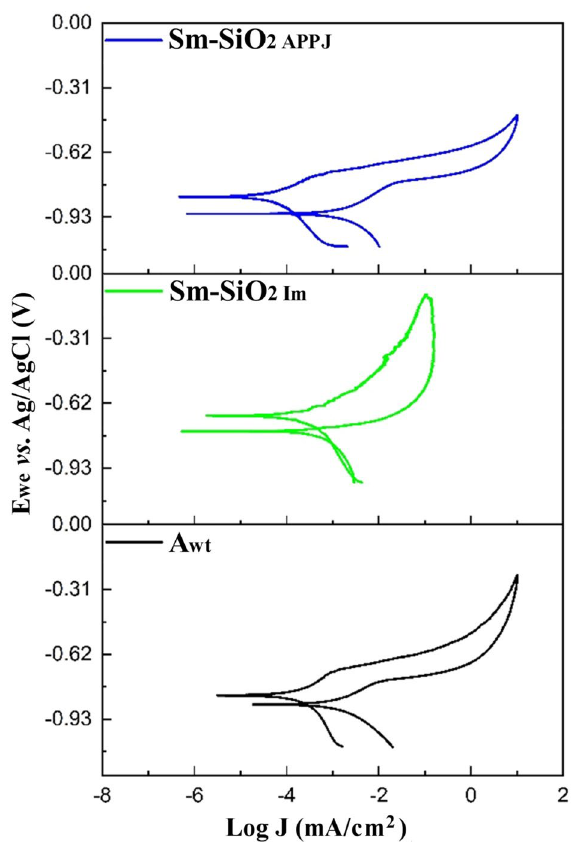
Figure 13. Cyclic potentiodynamic polarization for aluminum without treatment (A wt ), Sm–SiO 2 coatings by immersion (Sm–SiO 2 Im ), and APPJ (Sm–Si O 2 APPJ